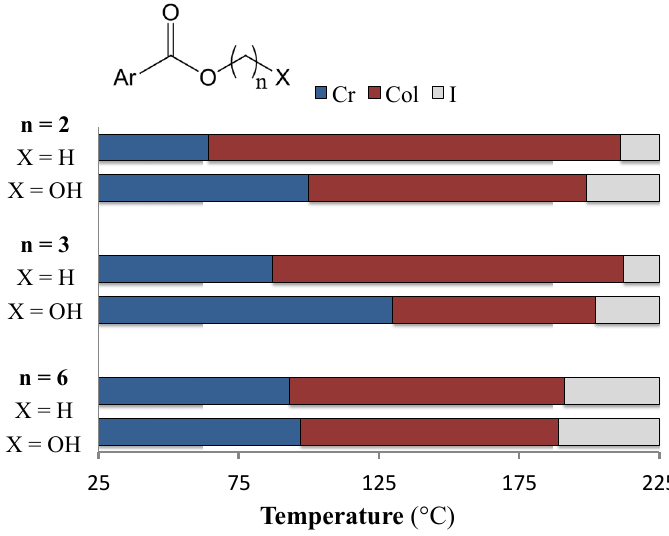
Figure 7. Phase ranges of compounds 2b , 2c , 2f and 6a – c ; Cr = crystalline solid, Col = columnar hexagonal LC, I = isotropic